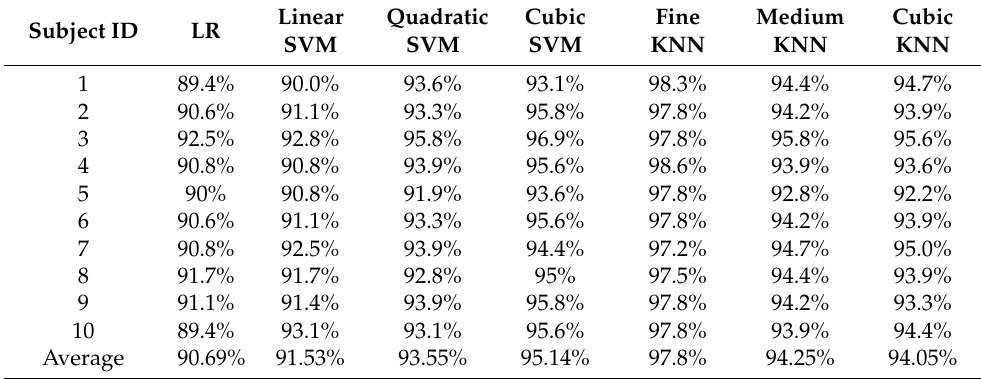
Table 2. Accuracy of leave-one-subject-out fatigue recognition.